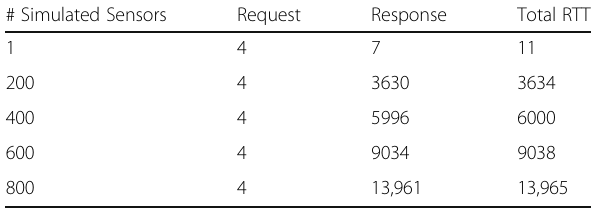
Table 5 Average Time to Transfer Modbus Data (ms) # Simulated